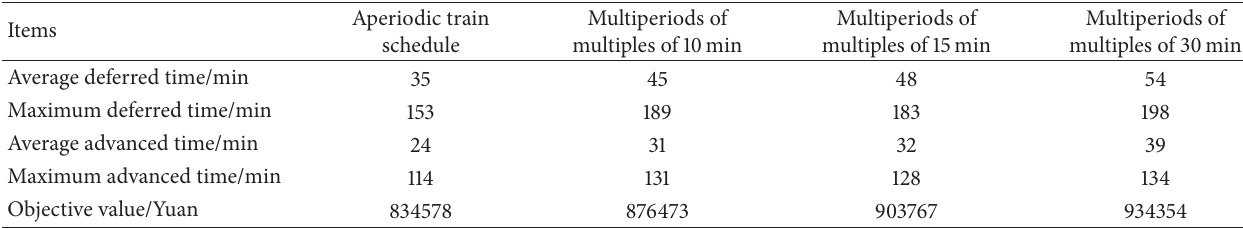
Table 5: The service level comparison between aperiodic and multiperiod mixed train